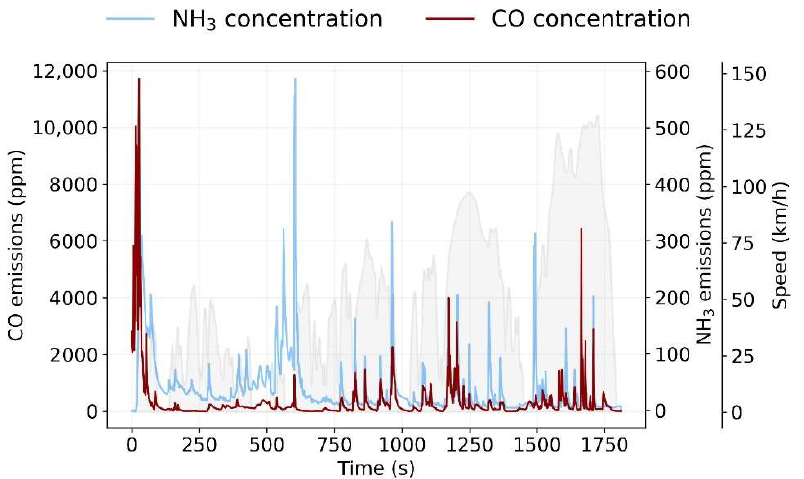
Figure 4. Example of CO (red line) and NH 3 (light blue line) emission profiles over a WLTC. Speed profile reported in grey.